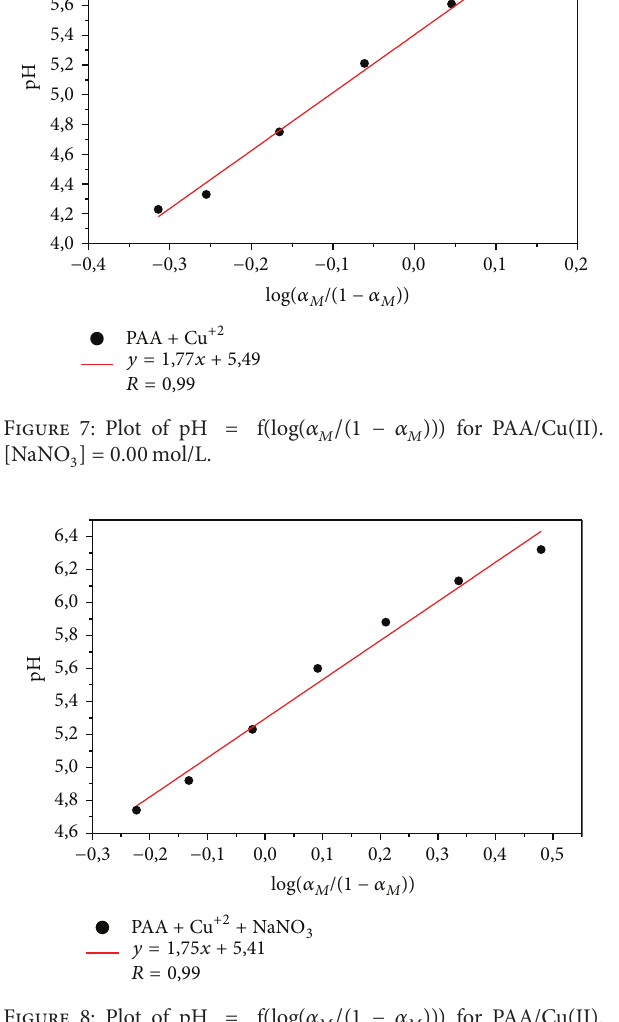
Figure 10: Plot of pH = f ( log (𝛼 𝑀 /(1 − 𝛼 𝑀 ))) for HQ-PAA/Cu(II). [NaNO 3 ] =